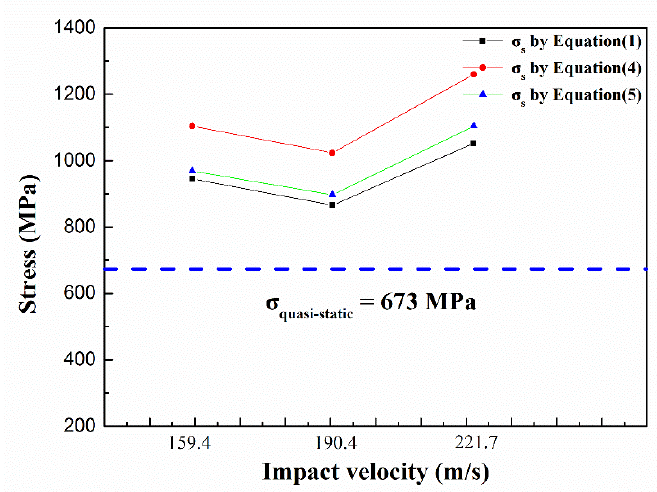
Figure 8. Dynamic yield stress calculated by three equations. The column in black was calculated by Equation (1), the column in red was calculated by Equation (4) and the column in green was calculated by Equation (5). The blue dotted line represented the quasi-static yield strength.